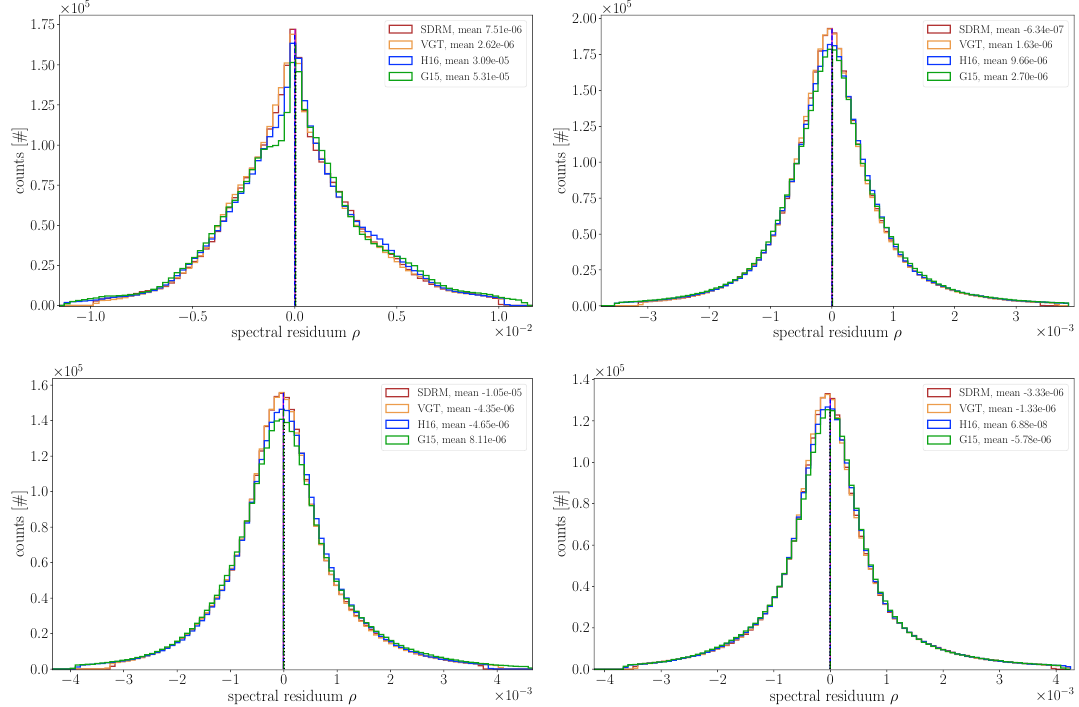
Figure 8. Distribution of the elements of the residual vectors for a single overpass per season in 2019 (Table 1). The histograms are shown per region, i.e. Sahara (top-left), Central-Europe (top-right), Amazonia (lower-left), and Siberia (lower-right). VGT represents cases for which the Voigt profile was calculated with SEOM line data input